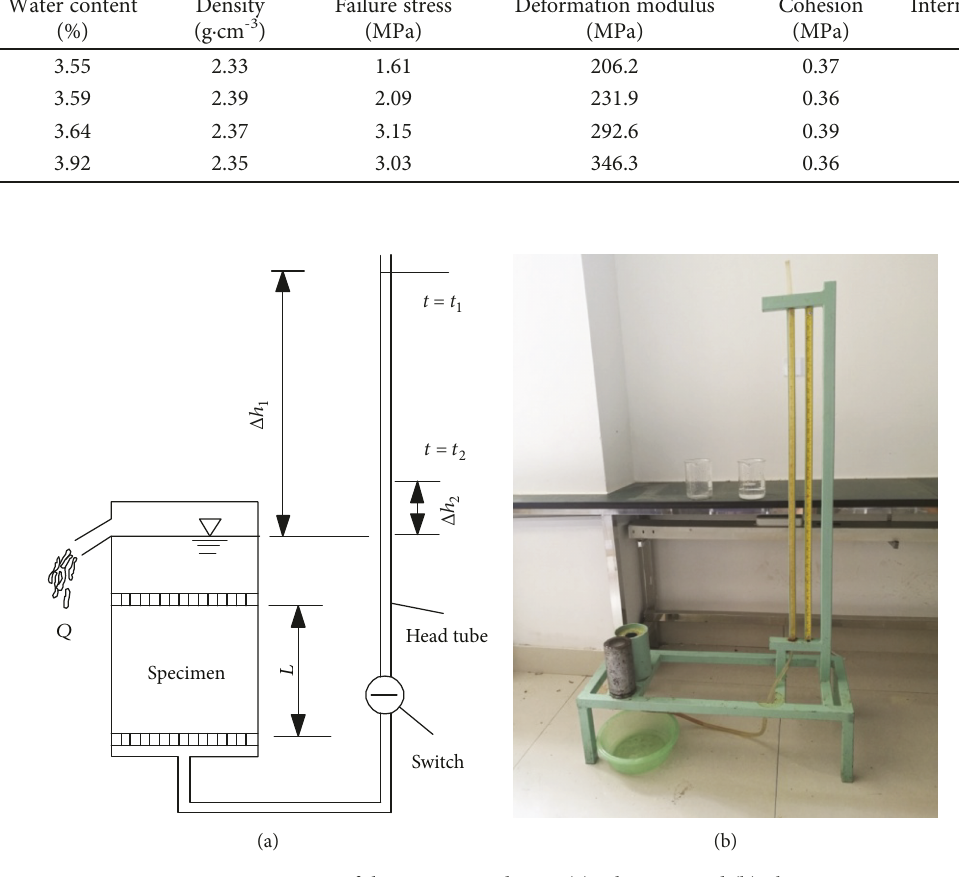
Figure 5: Diagram of the measuring device: (a) schematic and (b) object.